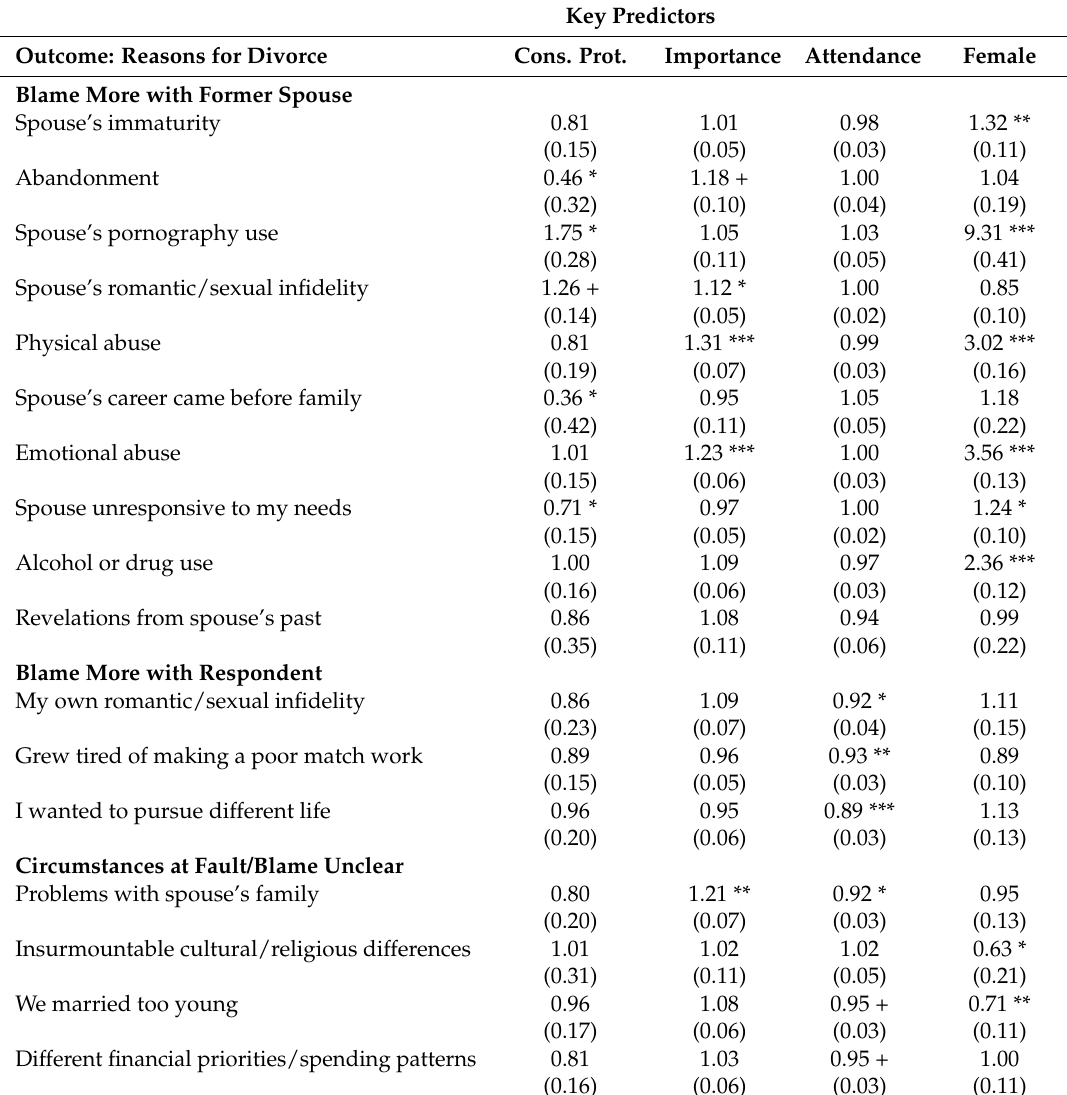
Table 3. Binary logistic regression models predicting retrospective reasons for divorce (full sample). Key